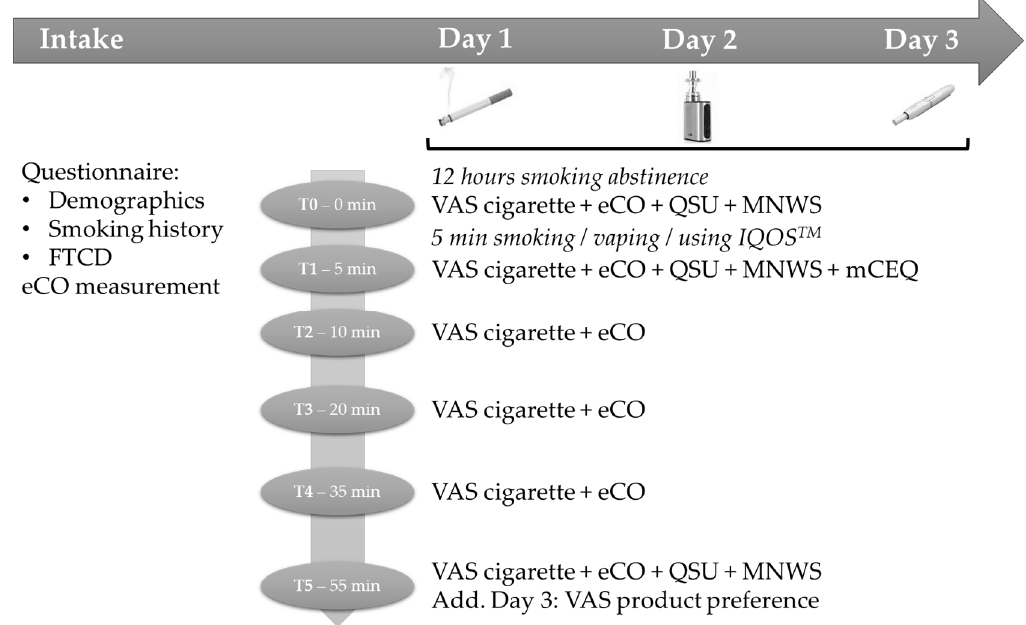
Figure 1. Study design and procedure.